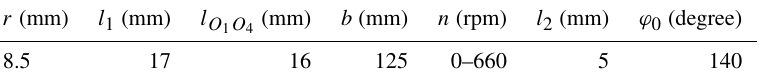
Table 1. The detailed specification of the mechanism.